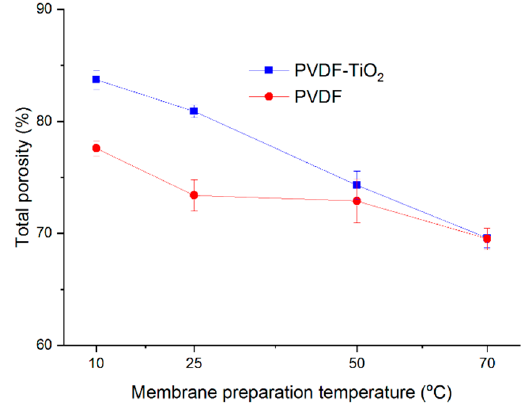
Figure 7. Membrane porosity.